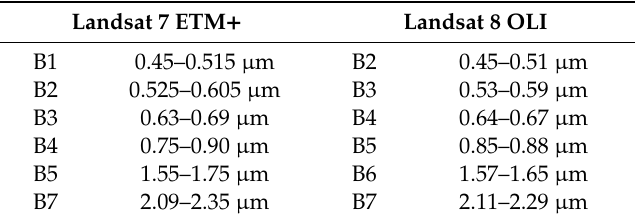
Table 1. Corresponding bands of Landsat 7 ETM + and Landsat 8 OLI.